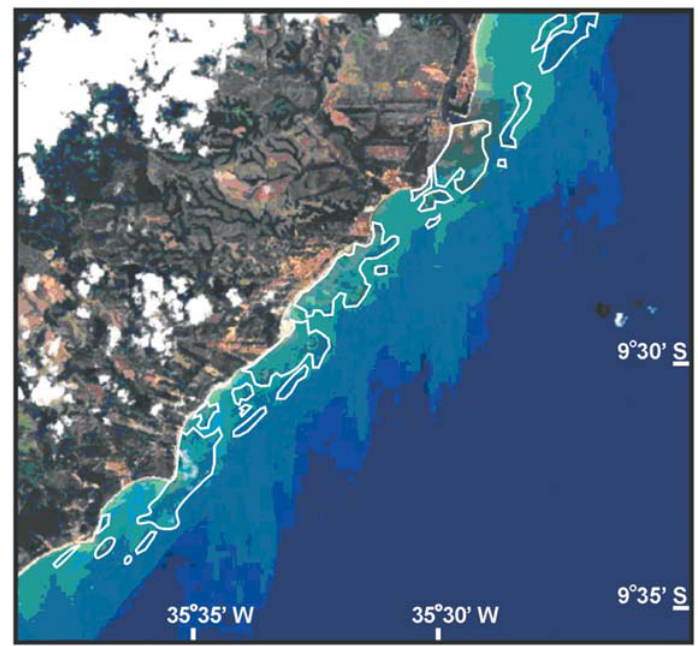
Fig. 2 – Landsat 7 ETM image illustrating two lines of shoreface bank reefs (highlighted in white line) parallel to the north coast of the state of Alagoas, 60 km north of Miaí (for location see Fig. 1).